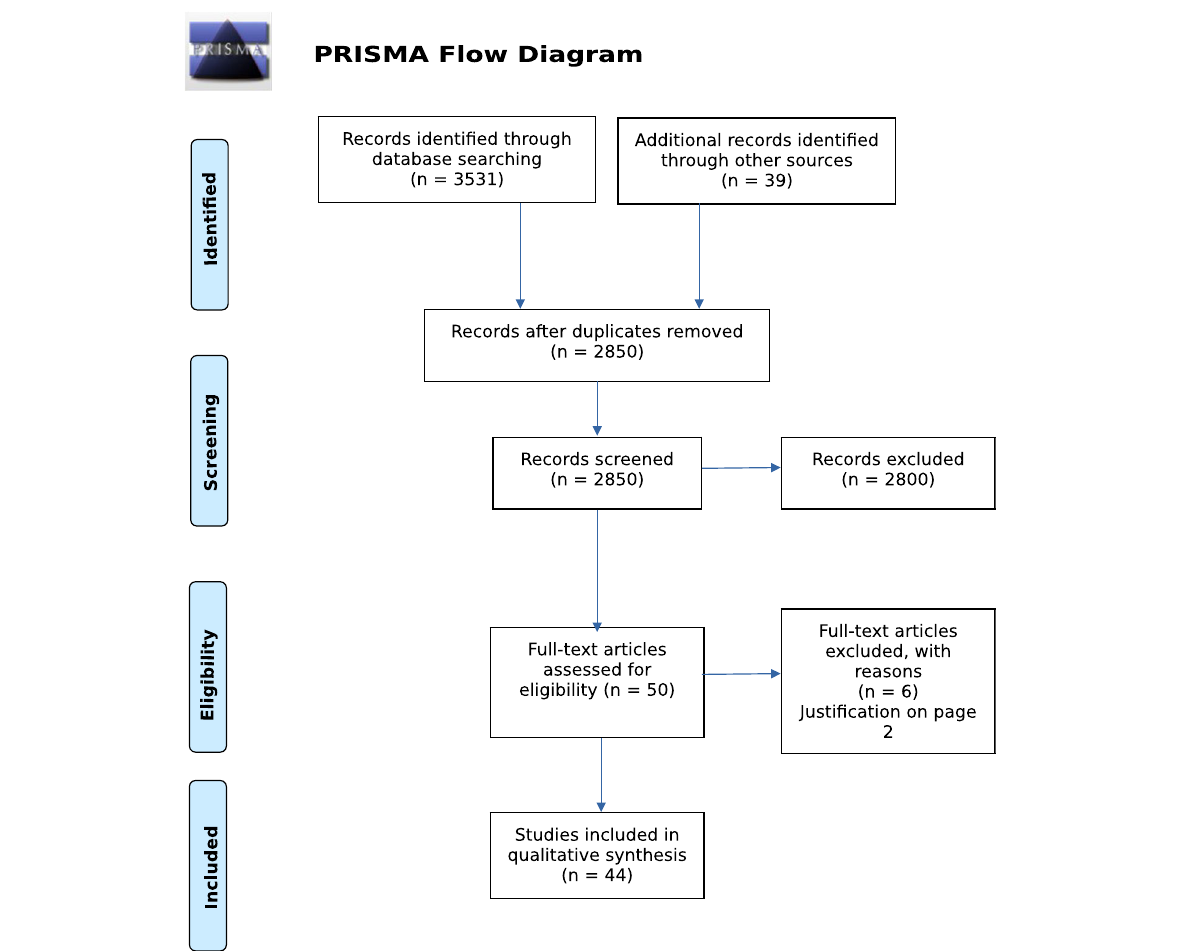
Fig. 1 PRISMA fl ow diagram. PRISMA fl owchart illustrating process of systematic review inclusion and explanation for excluded